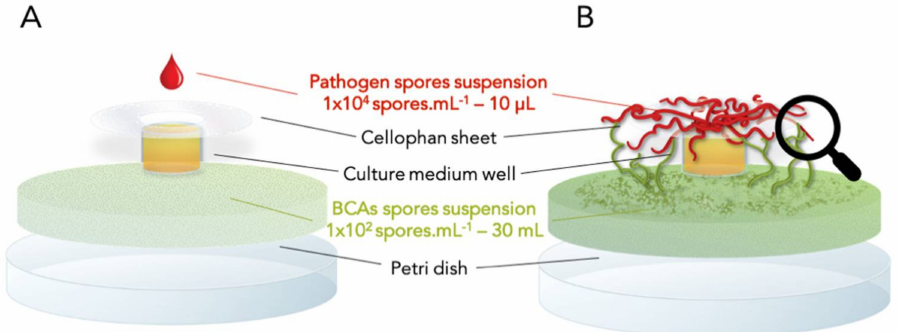
Figure 1. ( A ) Experimental device at beginning of test: in a Petri dish, a washed BCA spore suspension was dropped off around a culture medium well. CYA and PDA were used for F. graminearum and F. verticillioides , respectively. A cellophane sheet was laid around the well at surface of the BCAs suspension. Pathogen spore suspension was added in culture medium well at the beginning of the experiment; ( B ) experimental device after incubation of 20 days, pathogen was gradually coming out of the well and colonizing BCA suspension thanks to the cellophane sheet support. If BCA present a mycophagous activity, BCA colony could be observed at contact with alive pathogen. Magnifying glass indicates the global position of optical microscopic